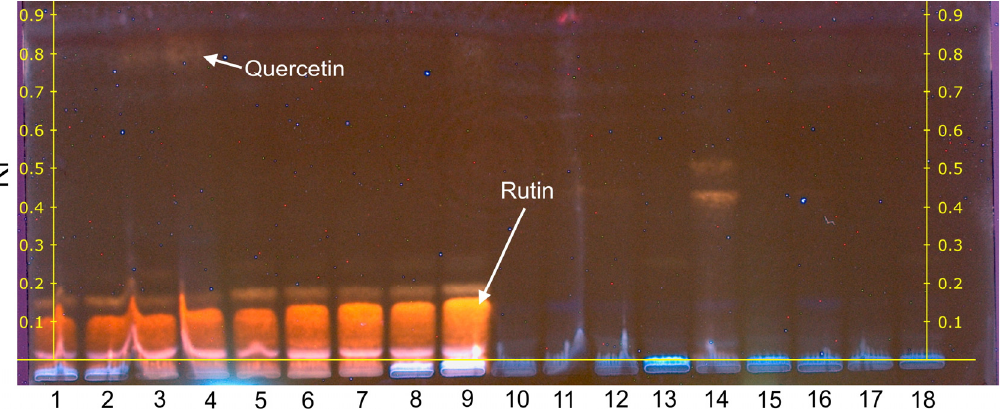
Figure 4. High-performance thin-layer chromatography of Betula and Pinus free PC extracts after derivatisation of DPPH • solution. Track indications: 1–9, Betula (injection volume 5 µ L); 10–18, Pinus (injection volume 10 µ L). Mobile phase consisted of acetone/chloroform/water (80:20:10 v / v / v ).